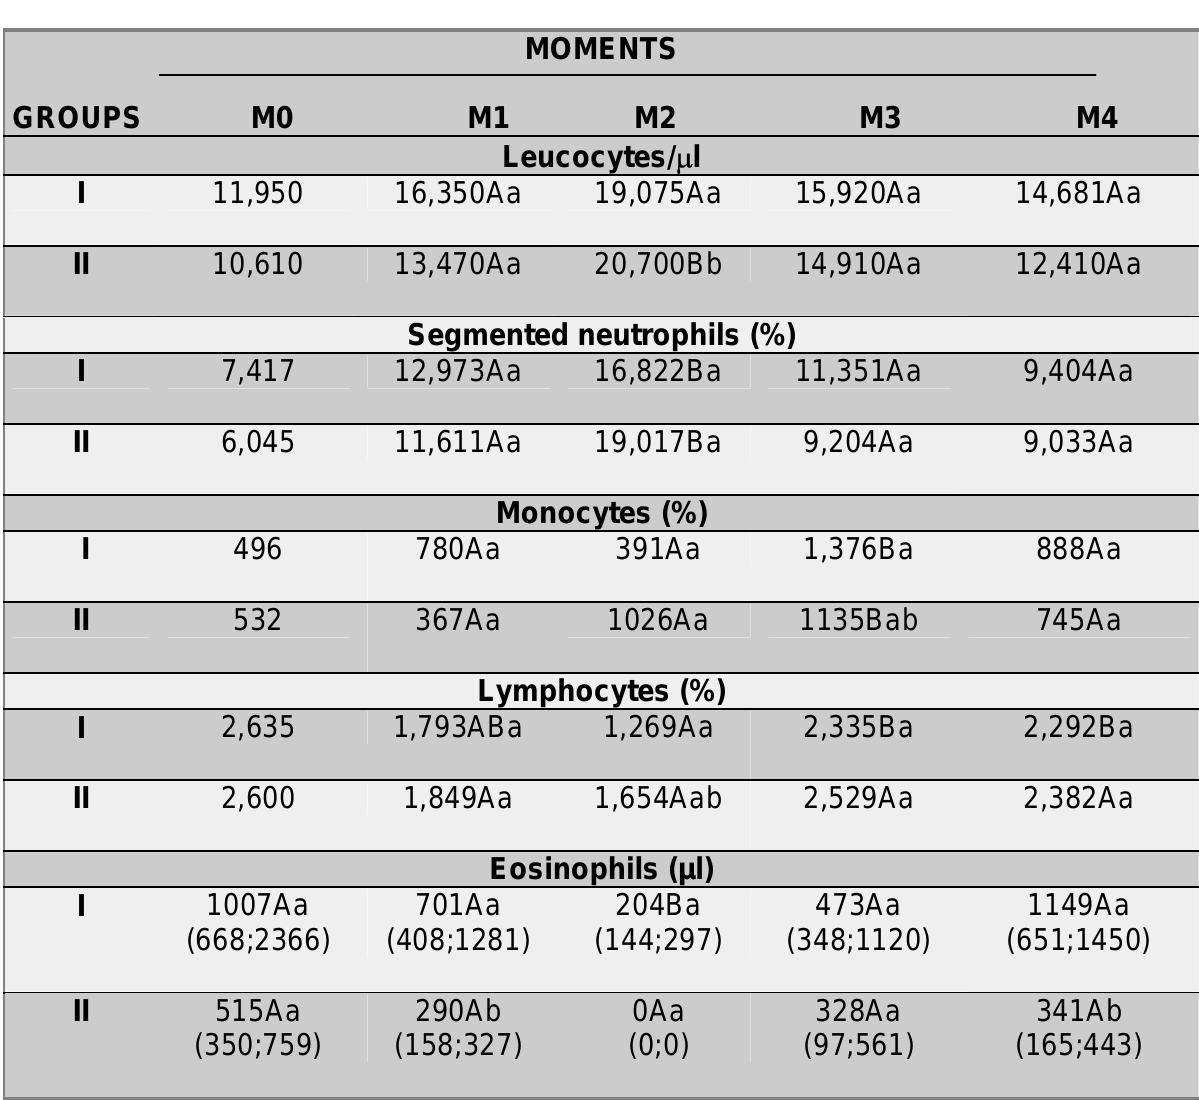
Table 3: Means of white blood cell count according to groups and